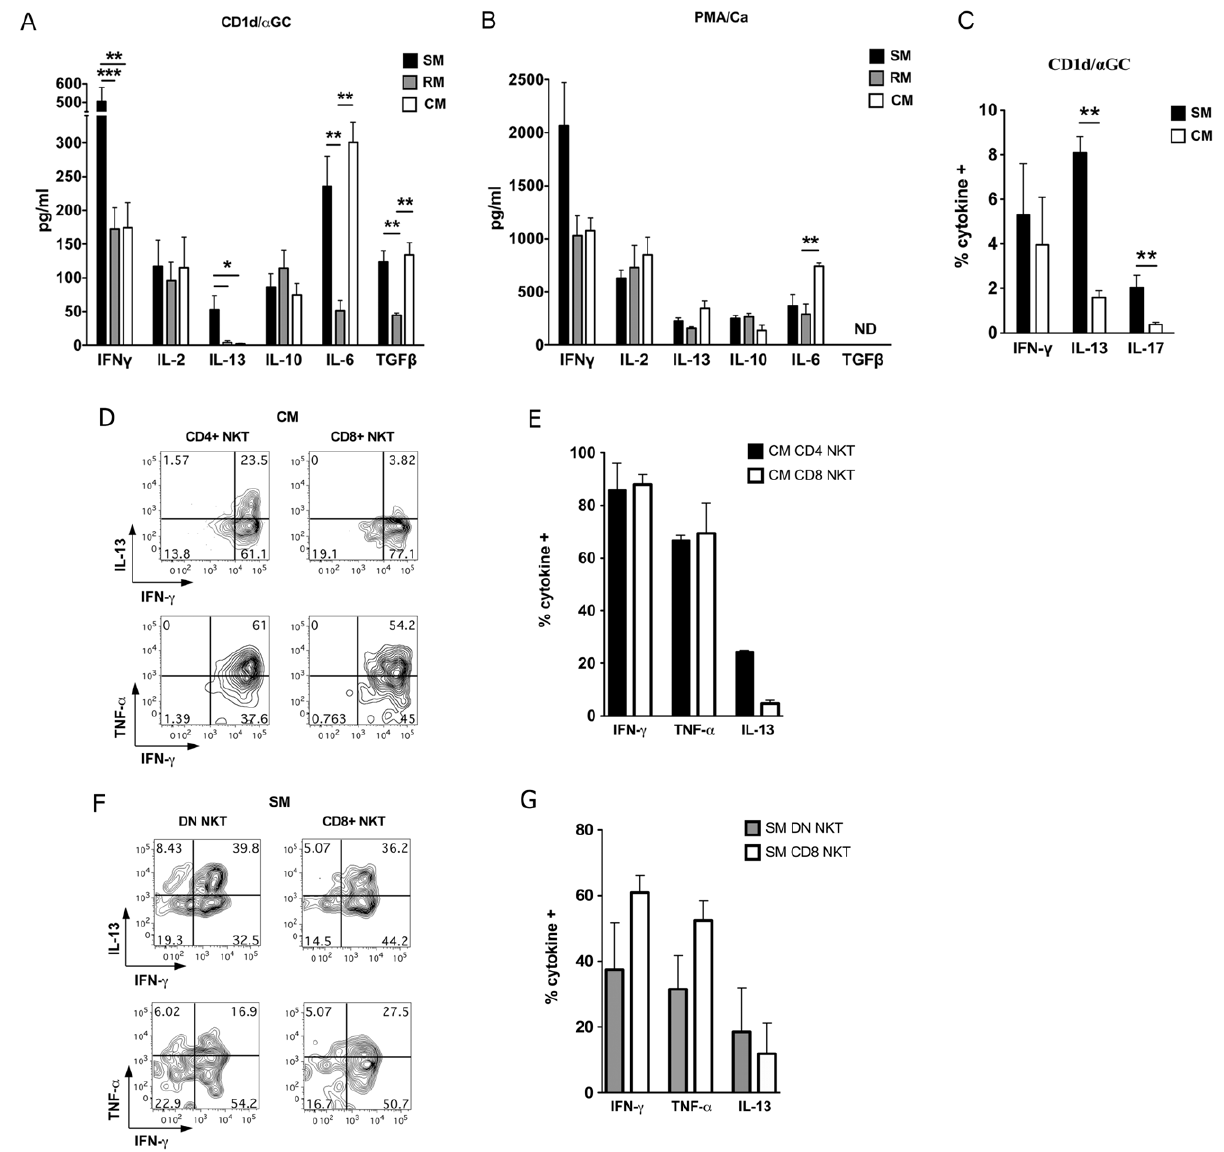
Figure 2. Th1 and Th2 cytokine secretion profiles of sooty mangabey (SM), rhesus macaque (RM) and cynomolgus macaque (CM) NKT lymphocytes. Cytokine ELISA for IFN- c , IL-2, IL-13, IL-10, IL-6, and TGF- b with culture supernatants collected 24 h following in vitro stimulation of SM, RM, and CM PBMC with (A) NKT ligand a -GalCer presented on CD1d expressing C1R cells (CD1d/ a GC) or (B) PMA/Ca ionomycin (PMA/Ca). C) Intracellular cytokine staining (ICS) data showing mean percentages of 12 h IFN- c , IL-13, and IL-17 production by in vitro expanded SM and CM NKT lymphocytes (stimulated with CD1d/ a GC). D) Contour plots showing ICS for IL-13, TNF- a , and IFN- c in ex vivo CD4 + and CD8 + NKT lymphocyte subsets from one SIV-negative CM following 4 hour PMA-stimulation. E) Bar graphs showing mean percentages of cytokine-positive NKT cells in the CD4 + (filled bars) and CD8 + (open bars) CM NKT subsets from two SIV-negative CM. F) Contour plots showing ICS for IL-13, TNF- a , and IFN- c in ex vivo DN and CD8 + NKT lymphocyte subsets from one SIV-negative SM following 4 hour PMA-stimulation. G) Bar graphs showing mean percentages of cytokine-positive NKT cells in the DN (filled bars) and CD8 + (open bars) SM NKT subsets in three animals. Data on gated CD3 + CD1dTM + shown. Error bars denote Standard Error of Mean. * P , 0.05 and ** P , 0.01 Mann-Whitney U